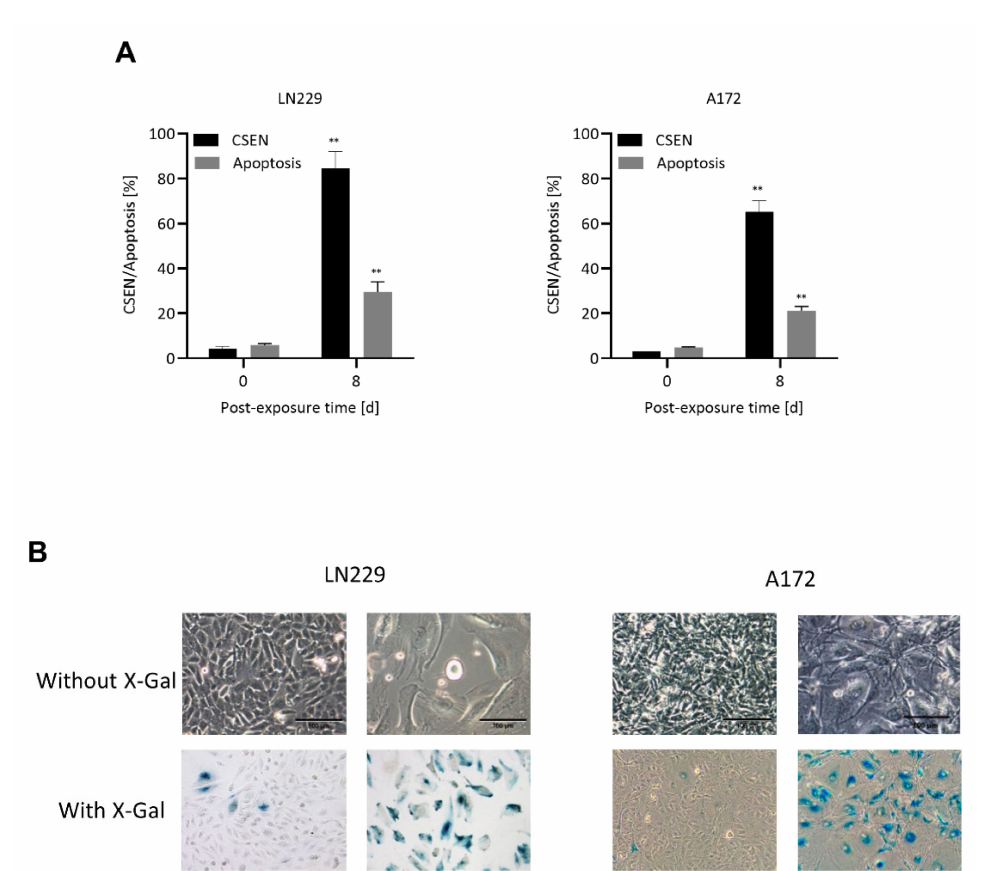
Figure 1. Induction of apoptosis and senescence. ( A ) Proliferating (day 0) and TMZ (50 µ M) treated LN229 and A172 cells (day 8) were measured for apoptosis and senescence via annexin/PI and C 12 FDG staining, respectively. TMZ treated cells display high amounts of senescence (CSEN) and low apoptosis levels. ( B ) Exemplary images of proliferating (left) and senescent (right) LN229 and A172 cells showing enlarged, flat morphology and SA- β -gal staining. Data in ( A ) represent the mean of 3 independent experiments ± SEM. ** p <